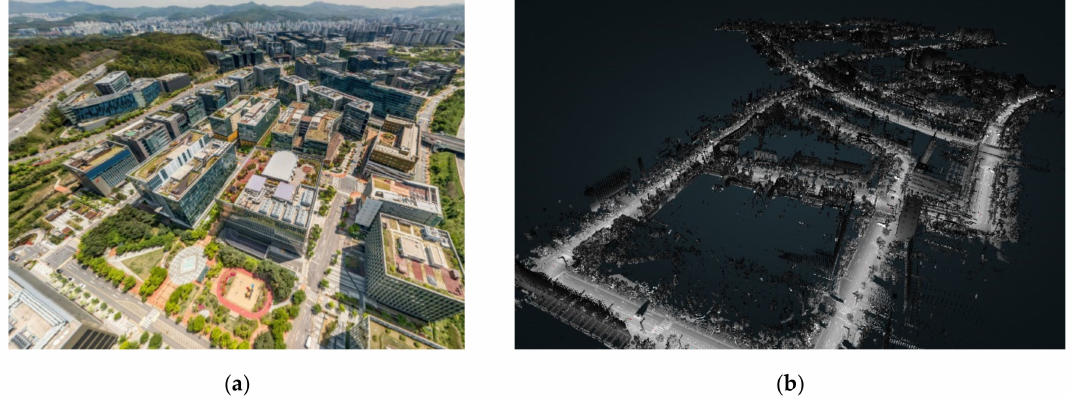
Figure 7. Aerial view of the test site in Pangyo, South Korea. ( a ) Aerial view (Naver Maps [33]), ( b ) Collected point cloud data [32].